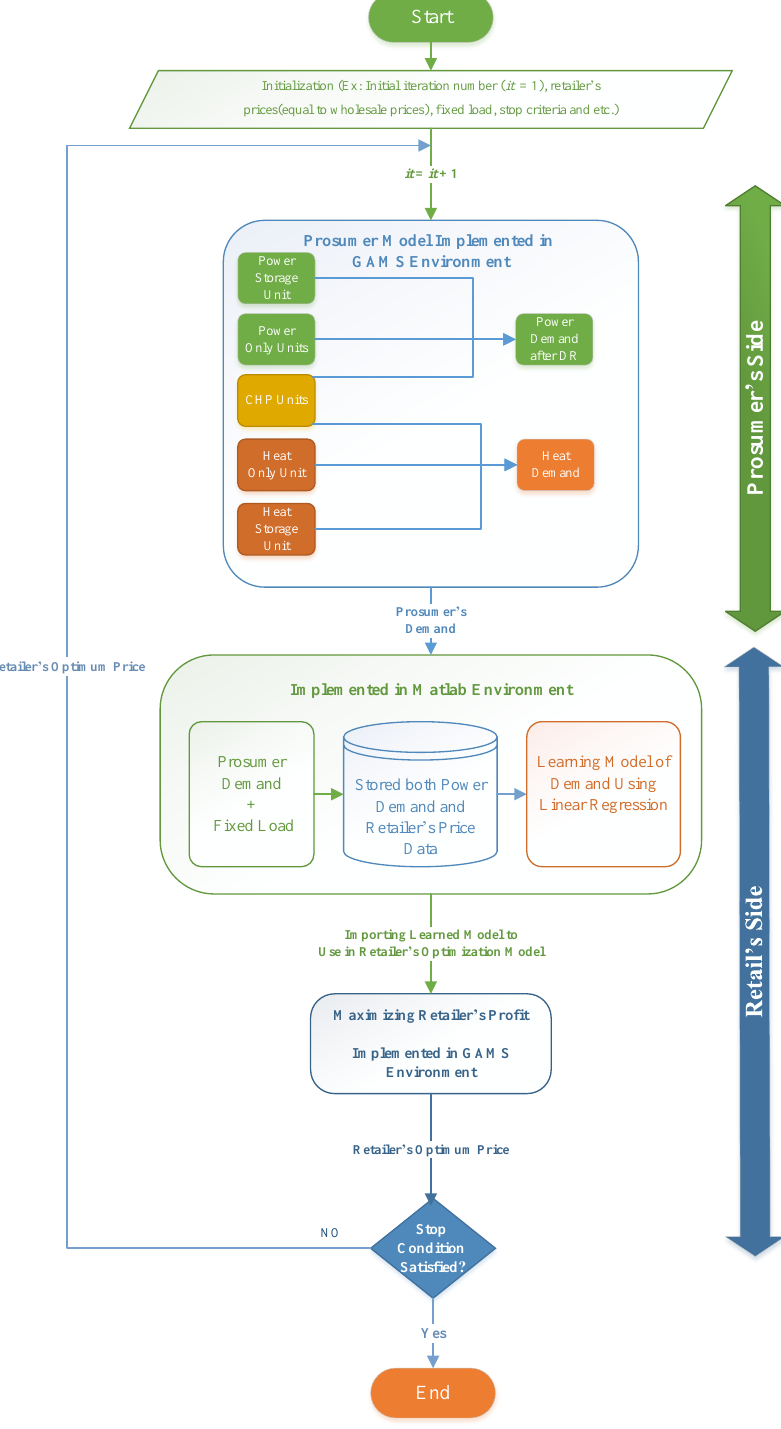
Figure 4. The proposed model of the retailer’s optimal bidding strategy in solving the CHP units allocation